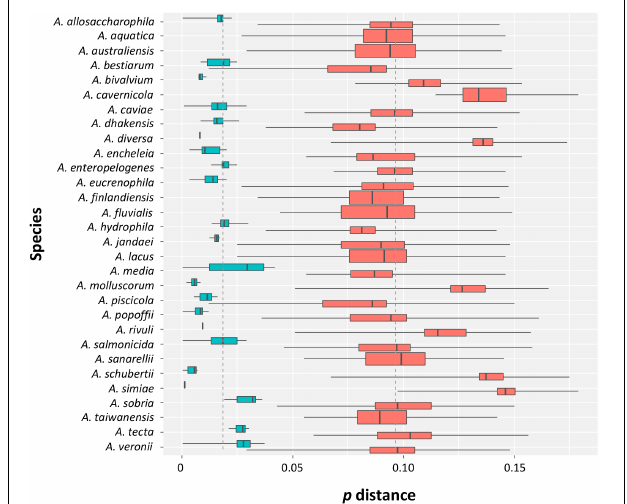
FIGURE 1 | Intra- and inter-specific distances in Aeromonas species. Box plots showing the intra- (turquoise) and inter-specific (salmon) p distances obtained from the data set. The ends of the boxes correspond to the first and third quartiles. The ends of the horizontal lines indicate the highest and lowest values. The black vertical line dividing the boxes represents the median of the